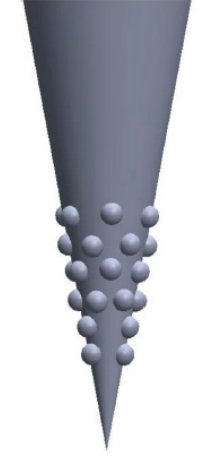
Figure 10. Configurations of the microneedle shape [311].